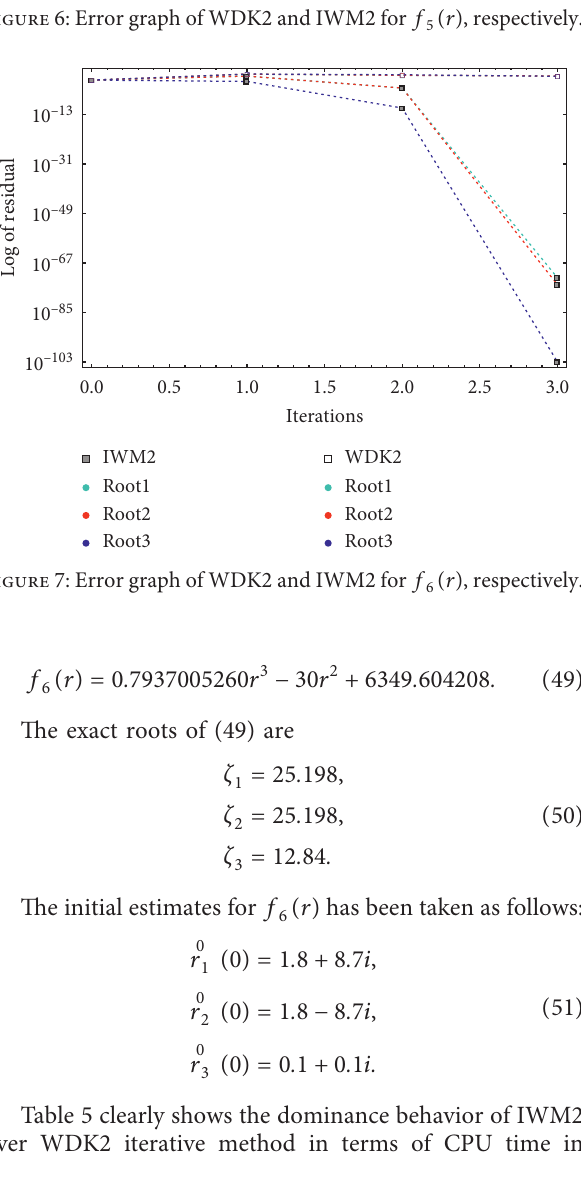
Figure 6: Error graph of WDK2 and IWM2 for f